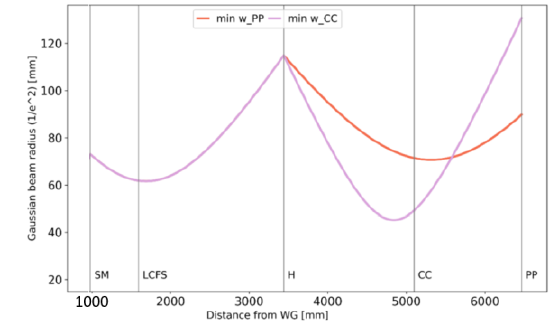
Fig. 8. Approximate beam envelope (1/e 2 power radius) for start-up. SM – steering mirror; mirror H, final fixed mirror; CC – centre column tile; PP - low field side Protection